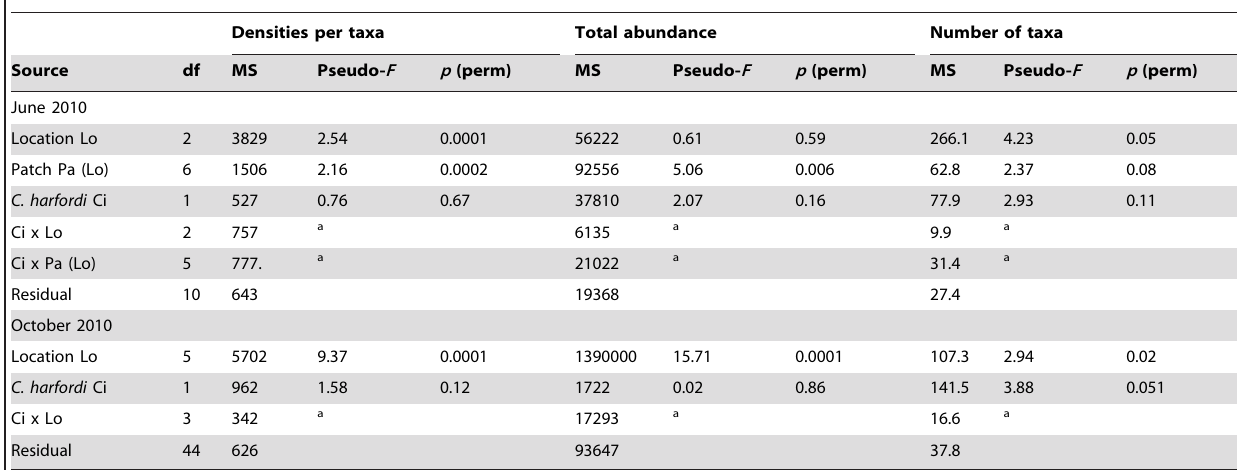
Table 2. Analyses of the effects of the densities of Cirolana harfordi on densities per taxa, total abundance and number of taxa of the assemblage in oyster-beds in June and October 2010. PERMANOVA (9999 permutations of residuals under reduced model) of Bray-Curtis similarities for the densities per taxa (forth root transformed) and Euclidean distances for total abundance and number of taxa in oyster-beds, where Location is the comparison among three locations in June and six locations in October 2010 (random) and Patch is the comparison among three patches per location (random, nested in Location), using the densities of C. harfordi as a covariate. Factor Patch was not included in the analysis in October 2010 (see methods). a Terms eliminated to increase the power for factors higher in the table.